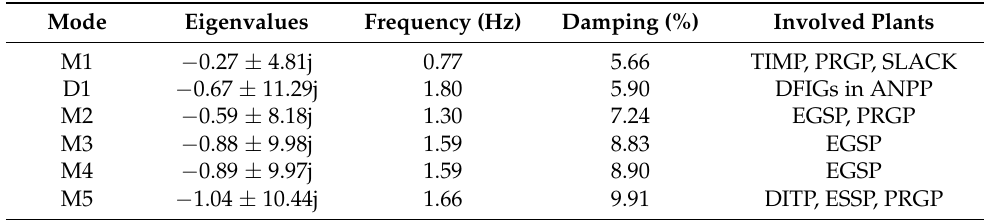
Table 10. Electromechanical modes below the threshold of 10% for the High Import DP.